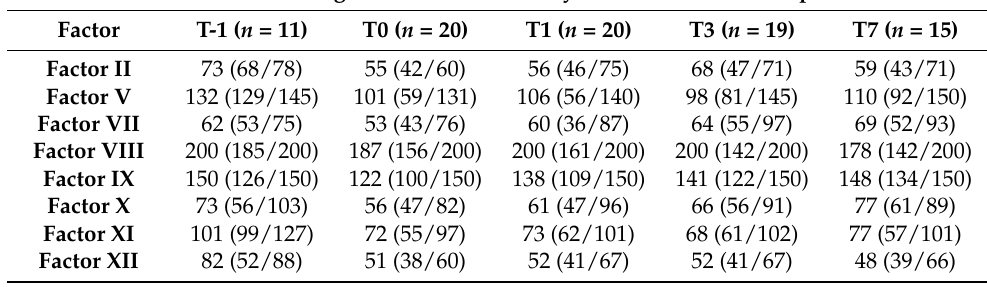
Table 1. Activity of different coagulation factors (excluding factor XIII (F XIII)) in acute respiratory distress syndrome (ARDS) patients before and after the initiation of veno-venous extracorporeal membrane oxygenation (vvECMO). Coagulation Factor Activity (%) at Different Timepoints Factor